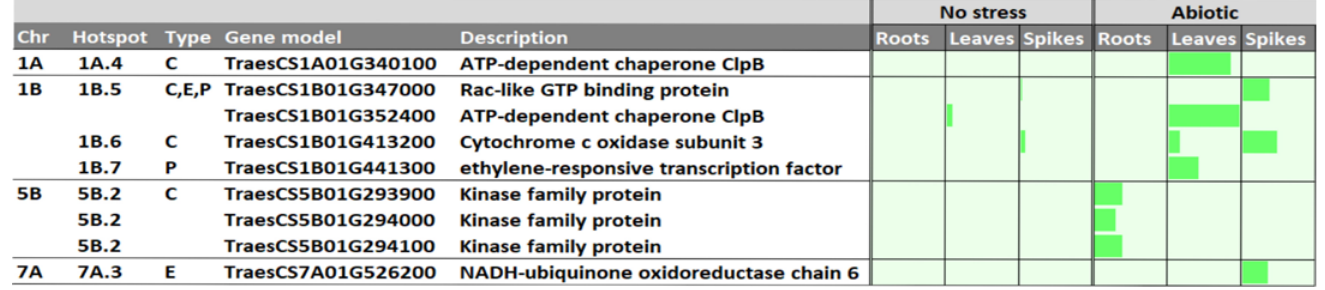
Figure 4. Upregulated CGs under abiotic stress conditions in three tissues Values are based on log2 tpm (dark green). CGs, candidate genes; tpm, transcripts per million. The length of the cells corresponds to 7.2 tpm.